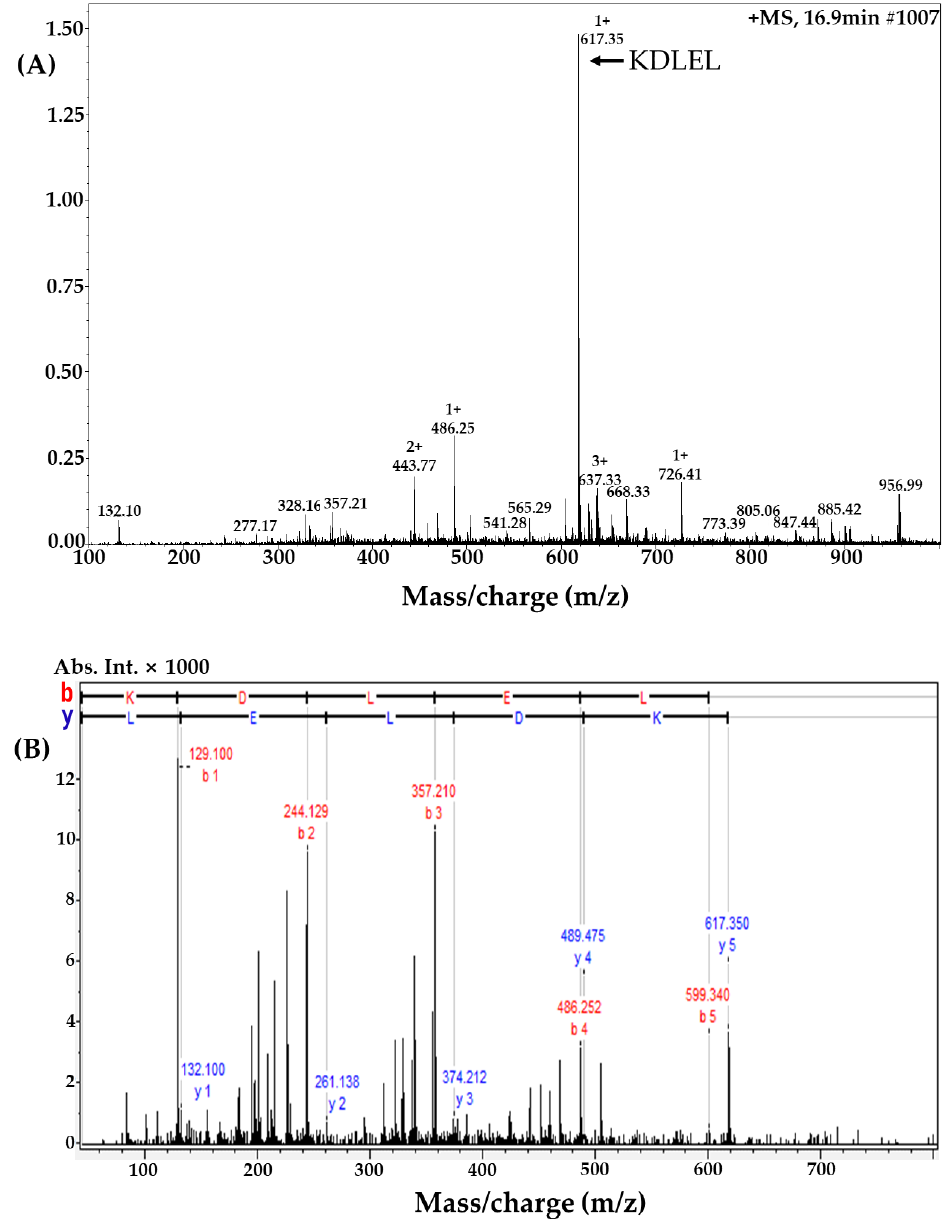
Figure 2. Molecular mass and amino acid sequence identification using sub-fraction 3 from MLPH fraction: ( A ) liquid chromatography–mass spectrometry; ( B ) tandem mass spectrometry (MS/MS) spectrum ( m / z 617.35).